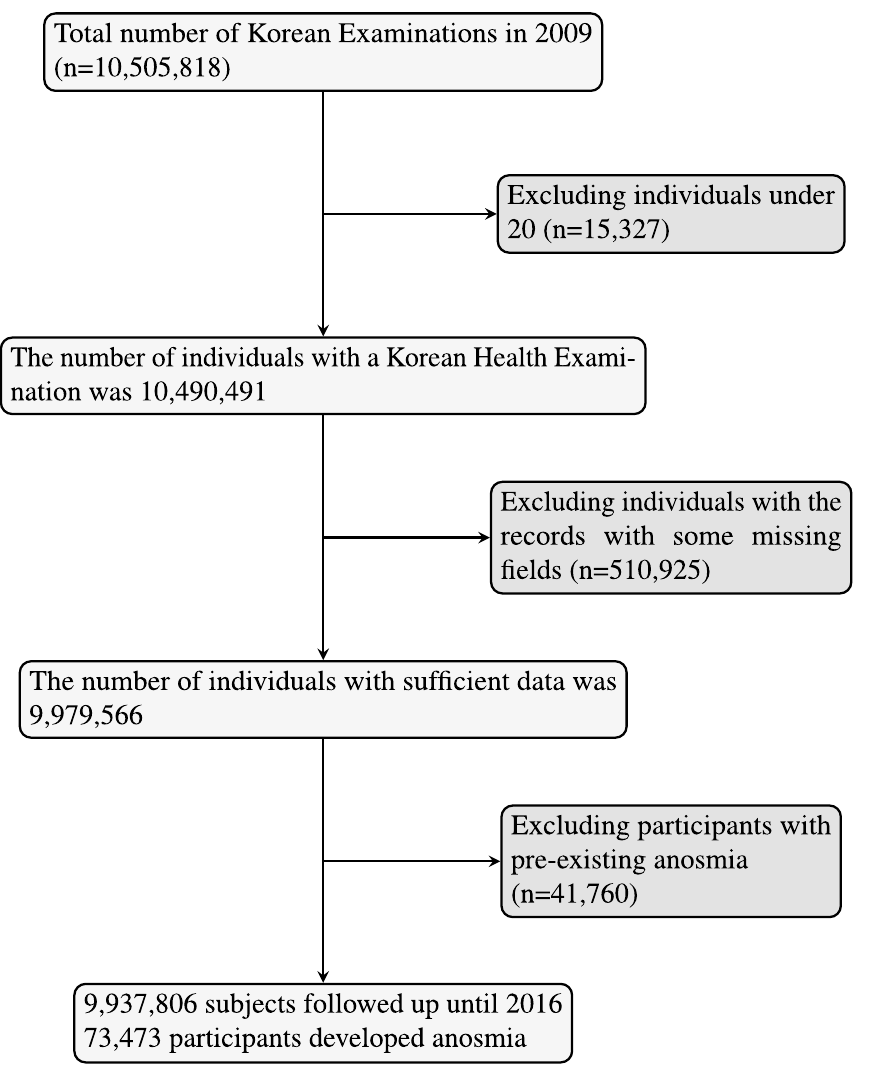
Figure 3. A flow chart of the